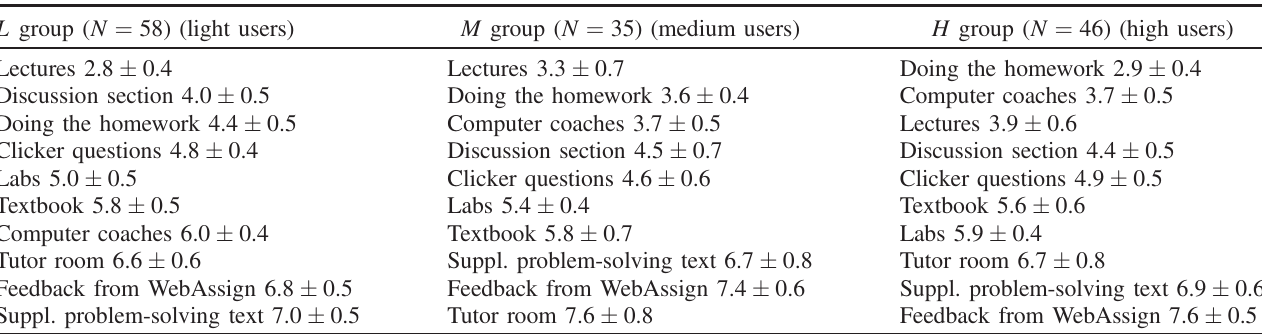
TABLE IX. Results from a spring 2013 end-of-semester survey question asking students to rank (with no ties), the usefulness of 10 components of the class to their learning, broken down by user group. Lower numbers are better.